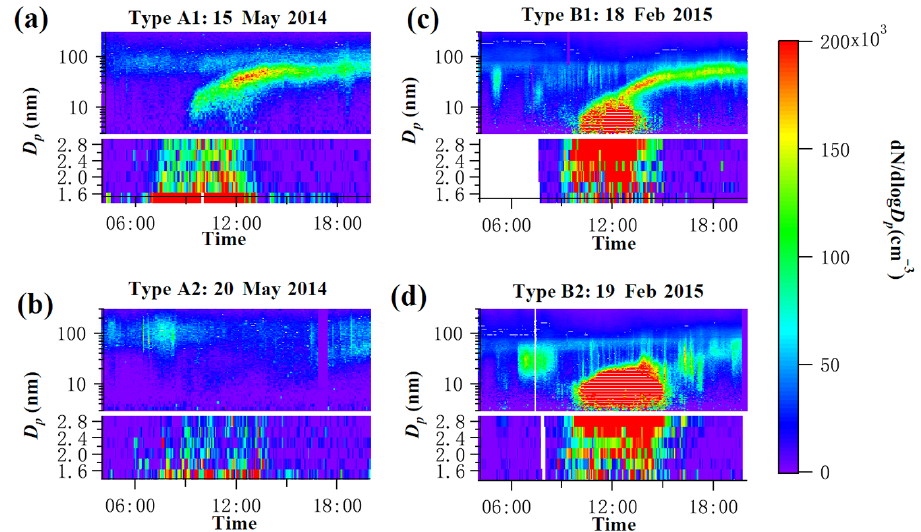
Figure 3. Size spectra of typical (a) Type A1 event on 15 May 2014, (b) Type A2 event on 20 May 2014, (c) Type B1 event on 18 February 2015, and (d) Type B2 event on 19 February 2015, during our measurement period. Size spectra from 3 to 300nm (logarithmic scale) and 1.4 to 3nm (linear scale) were obtained using SMPS and nCNC,